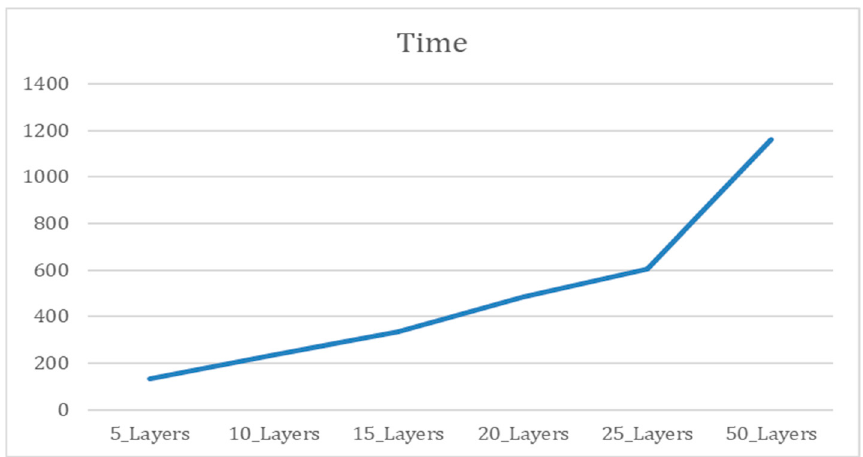
Figure 6. The average run time for each experiment.